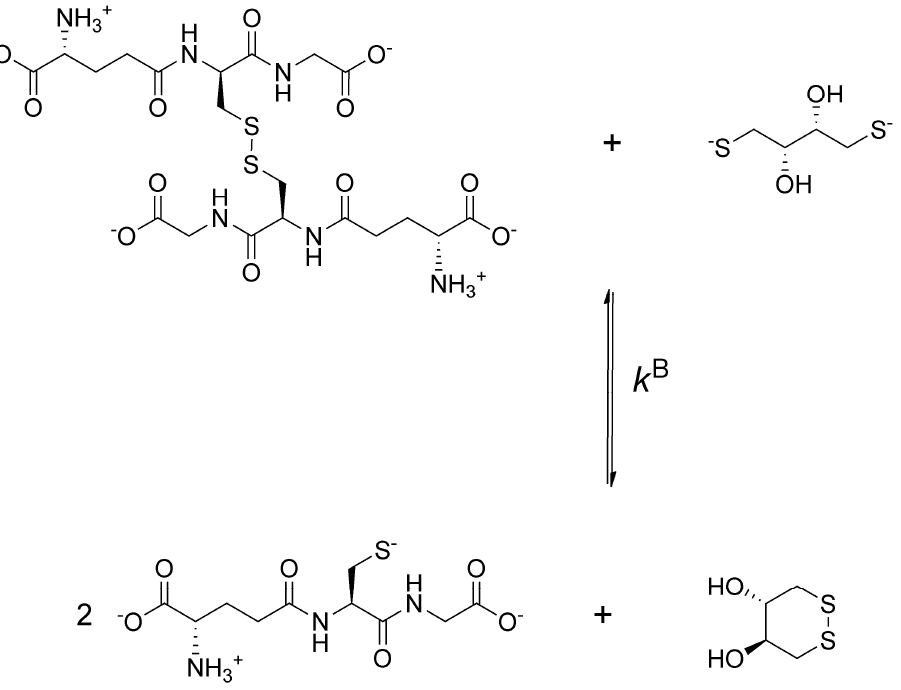
Figure 2. The redox reaction between oxidized glutathione and dithiothreitol (DTT) 2 − dominant microspecies at the pH of blood.